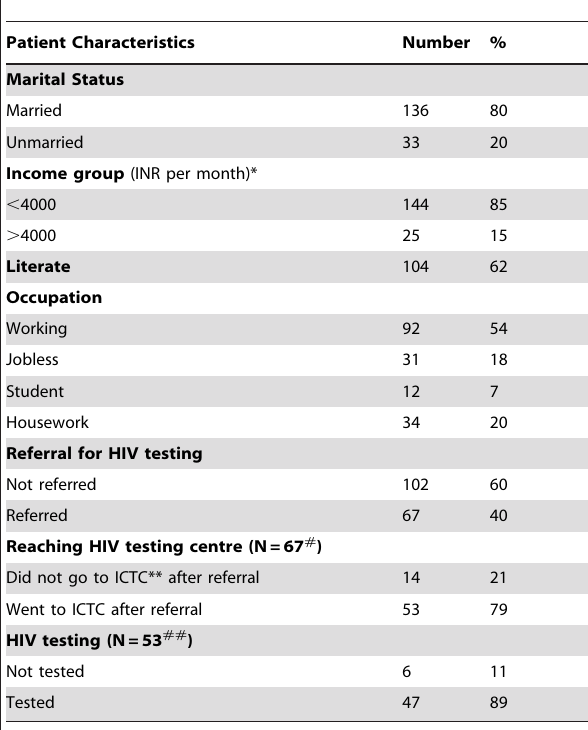
Table 3. Patient characteristics and HIV test referral outcomes as reported in interviews with patients with TB